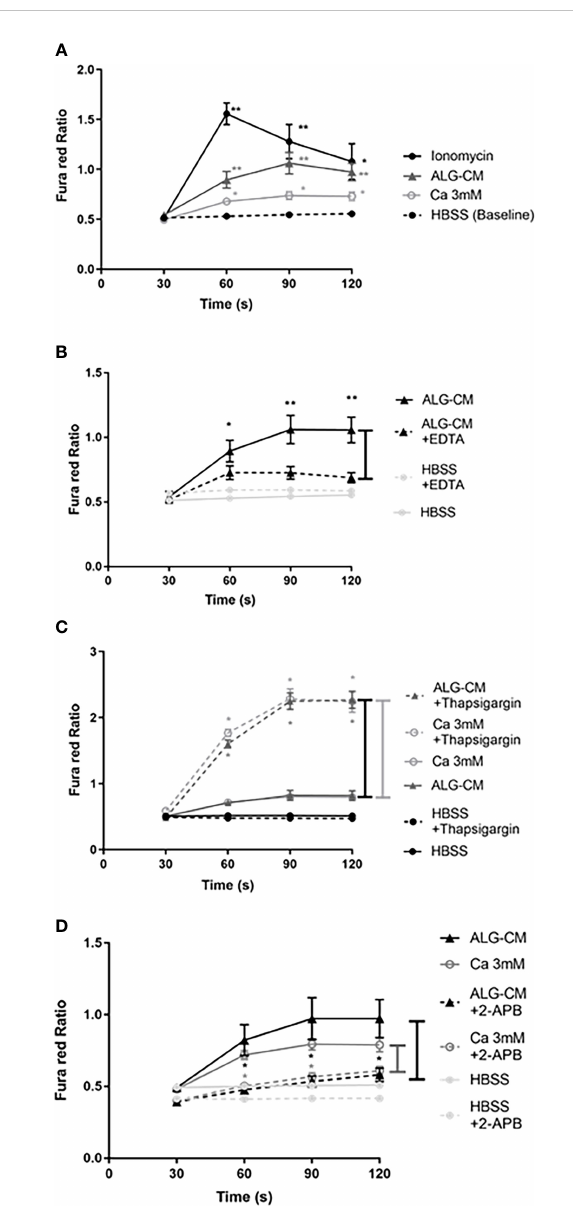
FIGURE 4 Fura red-AM Cytoplasmic calcium in fl ux in NK cells. Time- dependent calcium in fl ux in NK cells was measured by the Fura red Ratio detected every 30 seconds until 120s in each time interval (30s, 60s, 90s, and 120s) in HBSS solution. Ca 2+ in fl ux was measured after: (A) the addition of ionomycin as a positive control (1µg/ml) (circle, fi ll line), CaCl 2 solution at 3mM (white circle), ALG-CM (triangle), compared with control HBSS solution (baseline); (B) chelation of extracellular Ca 2+ released from ALG-CM using EDTA (10mM) diluted in conditioned medium (triangle, detached line) versus ALG-CM without EDTA (triangle, full line) or EDTA (10mM) diluted in HBSS (light grey circle, detached line) versus HBSS without EDTA (light grey circle, full line); (C) calcium store depletion with Thapsigargin (1µM), in the presence of CaCl 2 solution at 3mM (white circle) or ALG-CM (triangle); (D) blockade of Ca 2+ permeable channels 2-APB (100µM) in the presence of CaCl 2 solution at 3mM (white circle) or ALG-CM (triangle) or HBSS (light grey circle). Results are the mean ± SEM of independent experiments, using Wilcoxon paired test for statistical comparison to (A) HBSS baseline at each time interval with n=9, to (B) respective media without EDTA with n=9, to (C) respective media without Thapsigargin with n=6 or to (D) respective media without 2- APB with n=6. * p <0.05, ** p